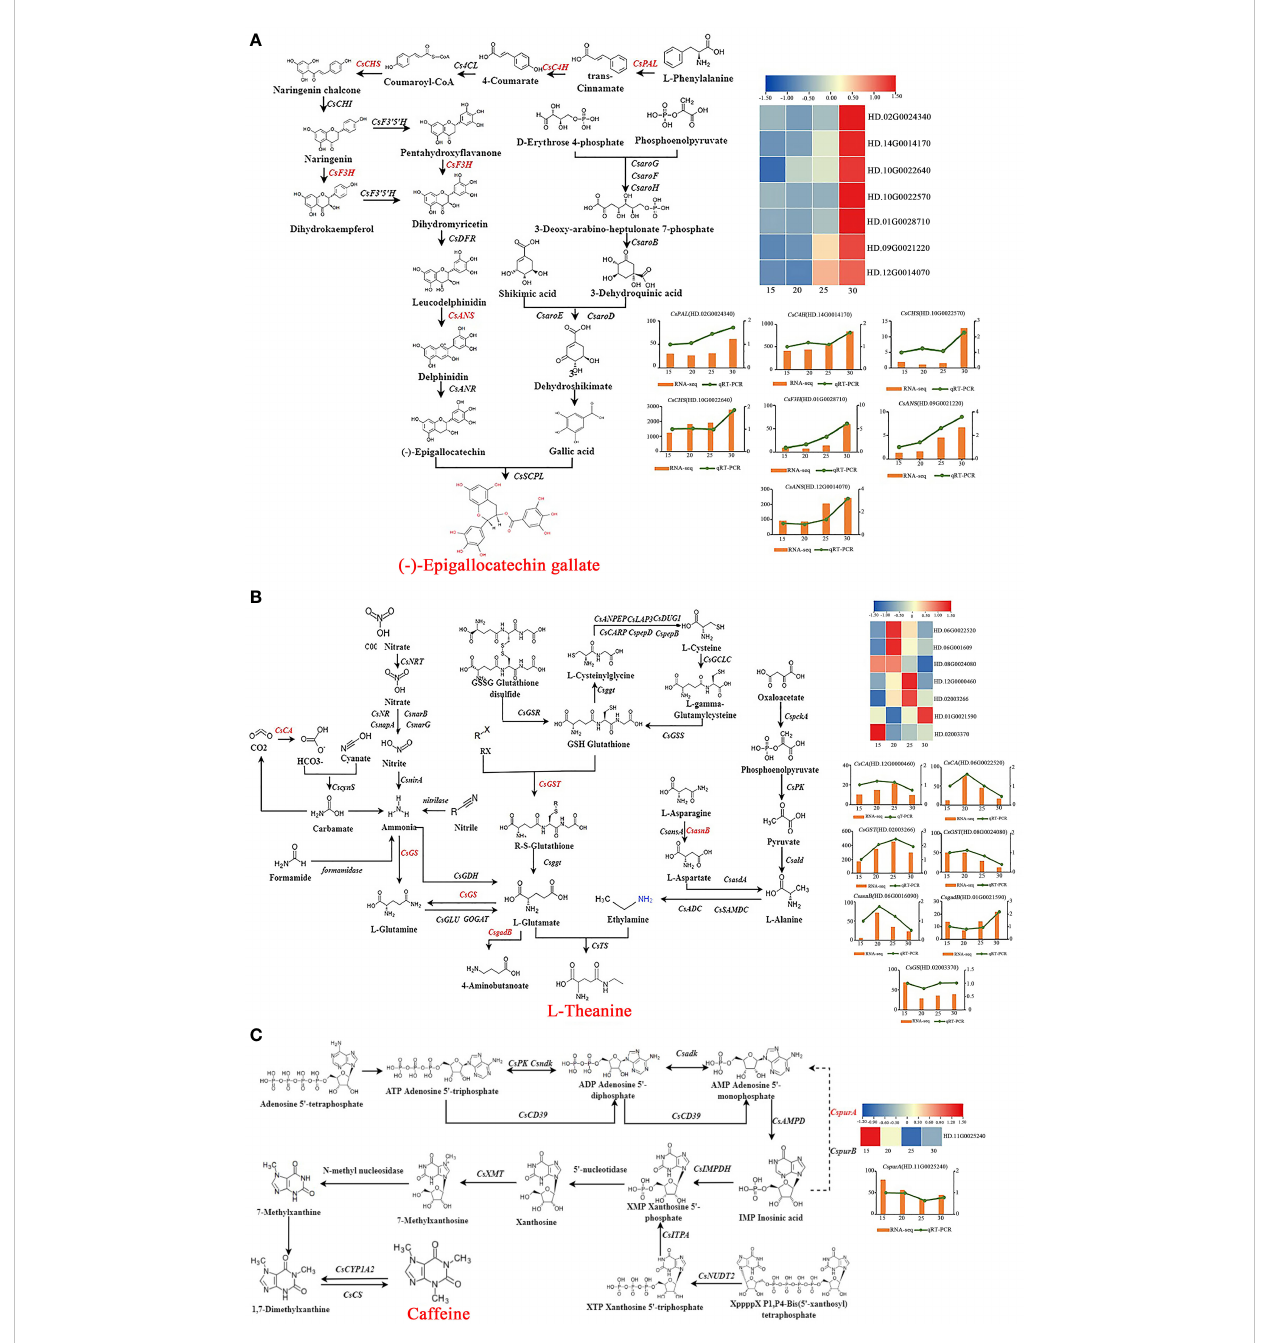
FIGURE 4 The biosynthesis of EGCG, theanine and caffeine in response to temperature. The biosynthesis of EGCG (A) , theanine (B) and caffeine (C)